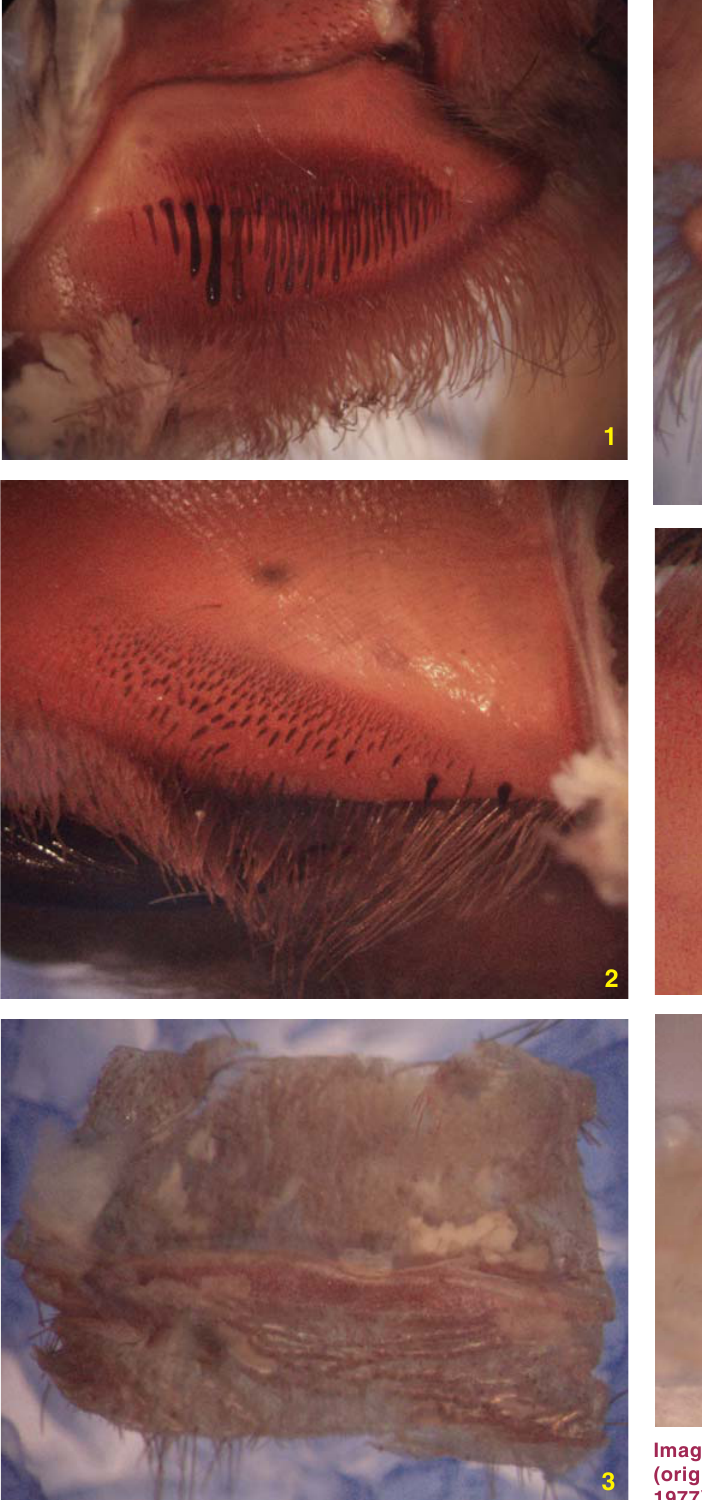
1-3. Chilobrachys fimbriatus Pocock, 1899 (originally described as Ischnocolus decoratus Tikader, 1977 based on immature holotype). 1 - maxilla, retrolateral view, showing stridulatory setae; 2 - chelicera, prolateral view, showing stridulatory setae; 3 - epigastral fold, dorsal view.